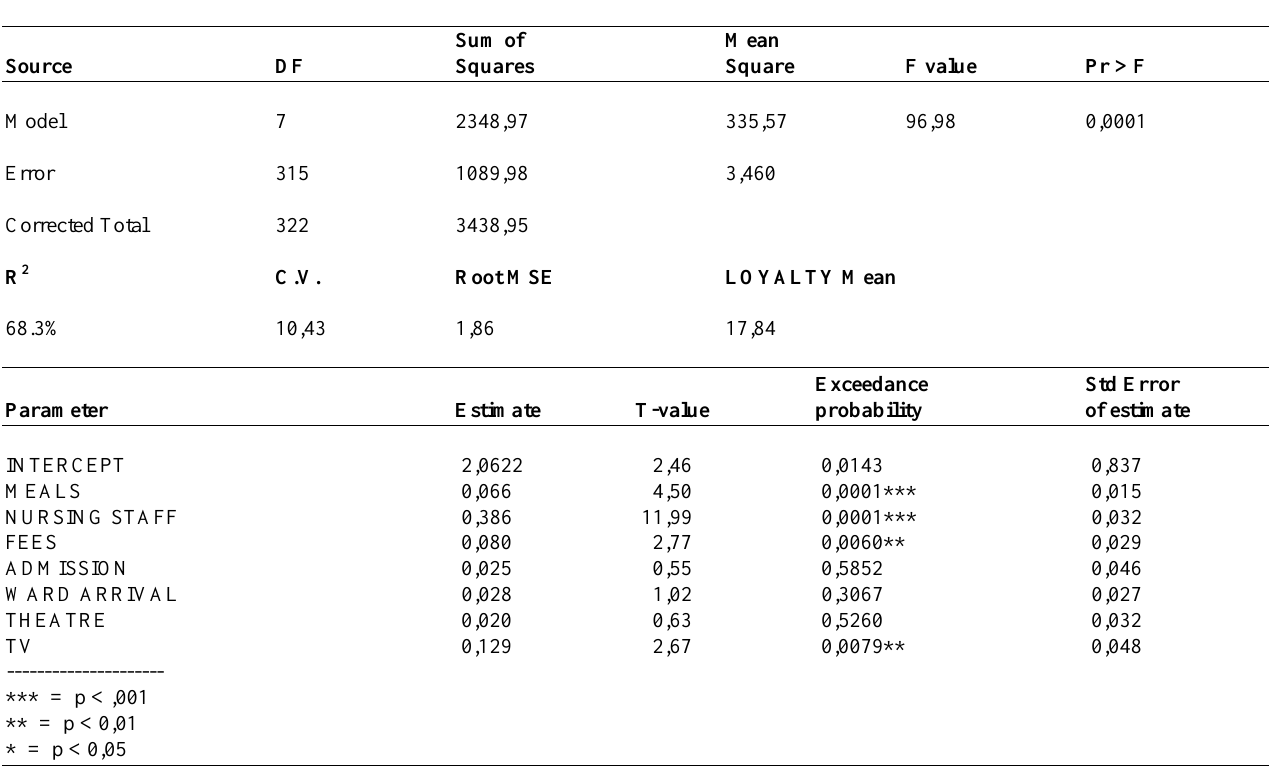
Table 5: Multiple regression results: Impact of satisfaction dimensions on loyalty Dependent Variable: LOYALTY (Willingness to re-purchase)